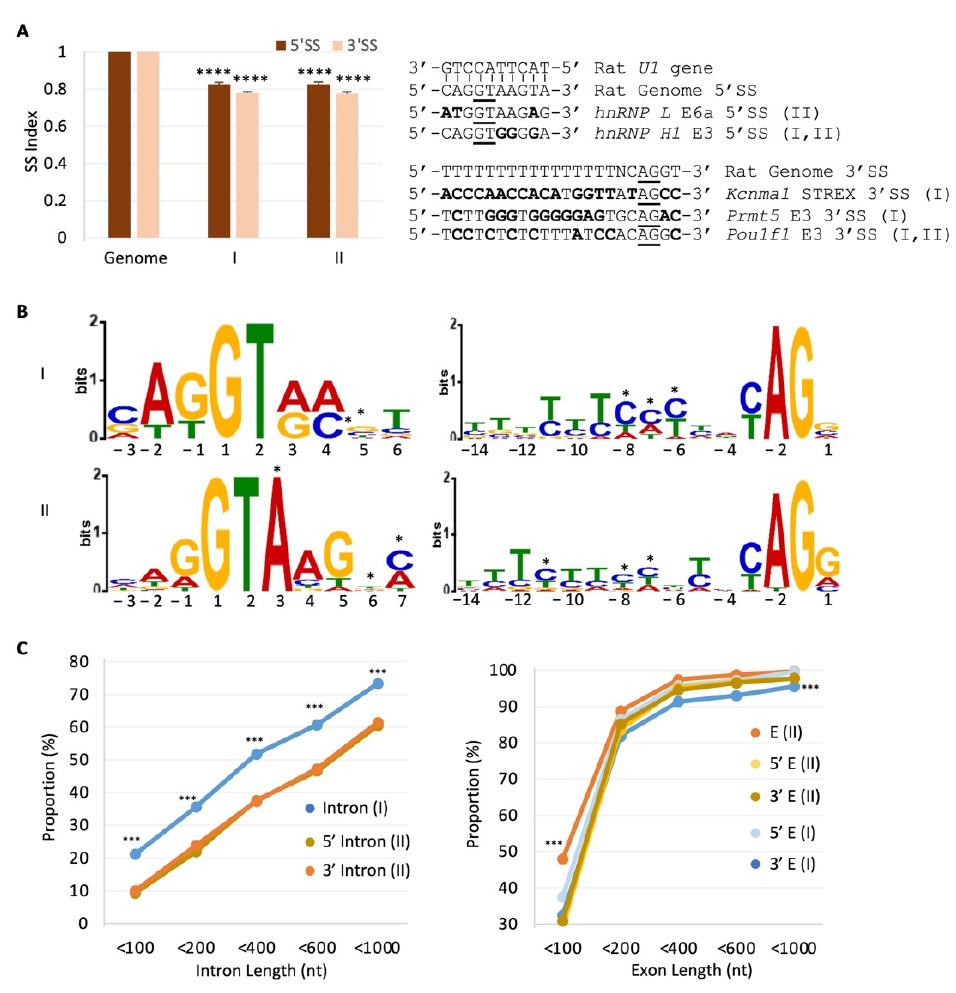
Figure 6. Properties of the RISE-associated splice sites, exons, and introns. ( A ) Indexes of the nucleotide matrices of the involved splice sites. Left: bar graphs of the splice site indexes of the most abundant nucleotides of the consensus splice sites of Rattus norvegicus (index = 1, Ref. [34], Nguyen and Xie, Gene ’18, using Ensembl Genome Metazoa Release 96), and the RISE-associated splice sites ( − 3–+10 for the 5 ′ SS, and − 20–+2 for the 3 ′ SS, Mean ± SEM, n = 186,851, 188,528, 67, 44, 48, 48 splice sites, from left to right). ****: p < 0.0001, one sample t -test compared to the genome. Right: examples of the RISE-associated 5 ′ or 3 ′ SS sequences. For the 5 ′ SS, the genome consensus matches perfectly with the complementary consensus region of 81 U1 snRNA sequences from rats. Nucleotides different from the genome consensus are in bold and the 5 ′ GT and 3 ′ AG are underlined. Bracketed are the associated types of RISE pairings. ( B ) Logo representation of the information content of the enriched nucleotides of the 5 ′ (Left) and 3 ′ (Right) splice sites with either type of the RISE pairing and DEXSeq p < 0.05, in comparison with the SS consensus sequences of the rat genome in ( A ) (Right panel). n = 28 (I, 5 ′ SS), 50 (I, 3 ′ SS), 34 (II, 5 ′ SS), 34 (II, 3 ′ SS) splice sites, and E -value < 1.3 × 10 − 28 and 5.6 × 10 − 42 , for the 5 ′ and 3 ′ SS, respectively. *: nucleotides deviated from the species consensus. ( C ) Percent distribution of intron/exon lengths. Left: intron length distribution. ***: p < 6.7 × 10 − 10 , hypergeometric density test compared to either 5 ′ or 3 ′ introns of the exons flanked by type II RISE pairings. Right panel: similarly as in the left, but for exon lengths. ***: p < 4.3 × 10 − 6 , E (II) in comparison with the 5 ′ or 3 ′ E (I). E: exon. n = 644 or 311 introns/exons, for each type I or II data point (non-overlapping), respectively.